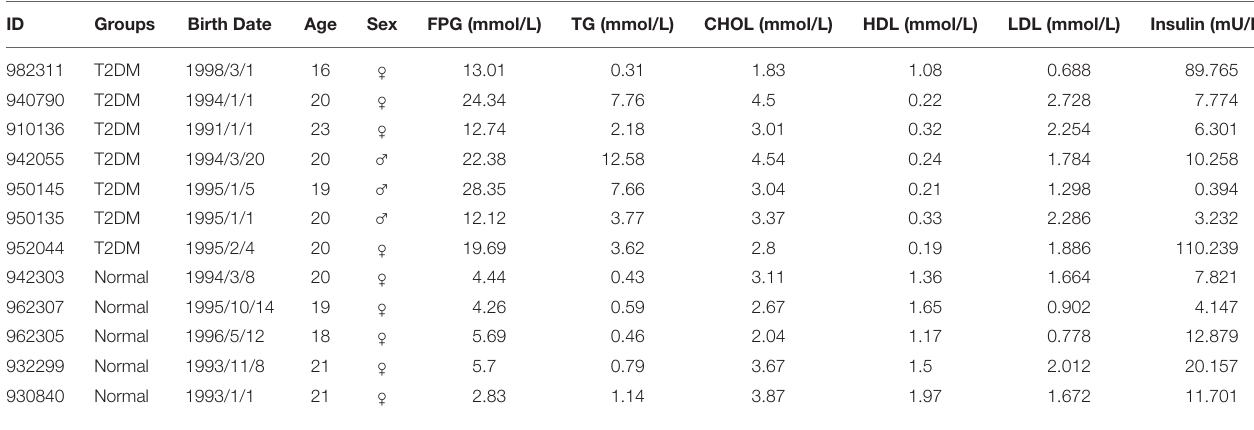
TABLE 1 | Animals information and Biochemical Indicators